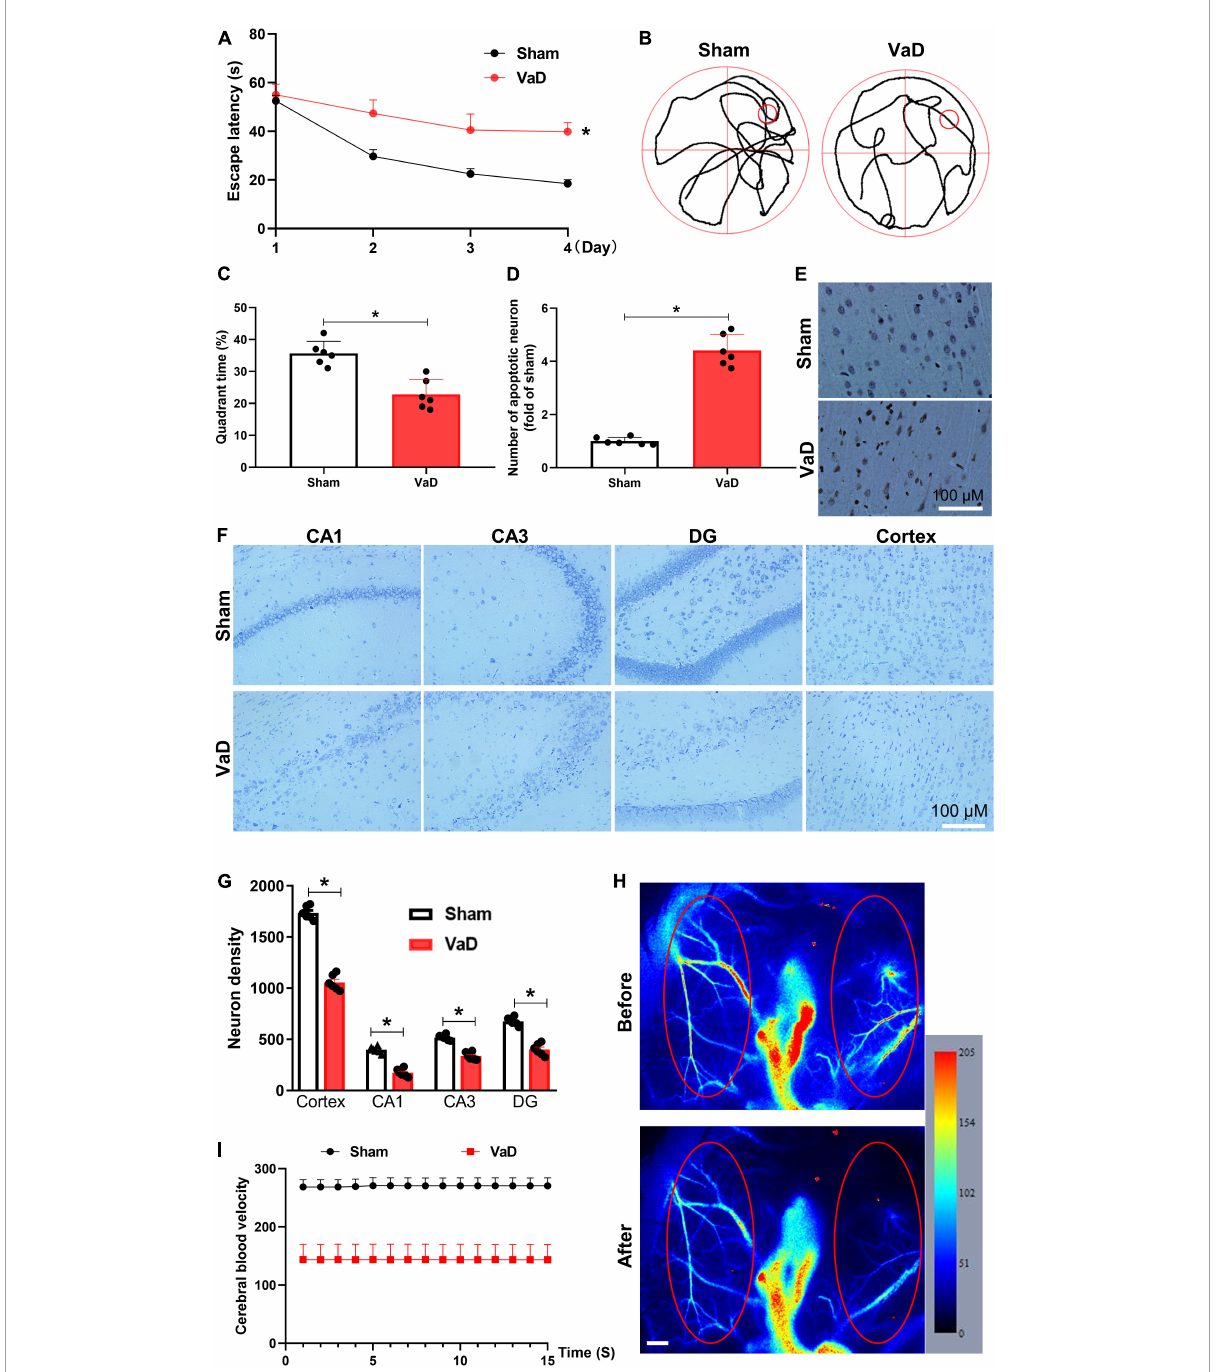
FIGURE3 Establishing of VaD rat model. Sprague-Dawley rats were subjected to bilateral common carotid artery occlusion surgery to induce VaD rat model. Three months later, the Morris water maze (MWM) test was performed, then brains were collected for histopathological analysis. (A) The trajectory chart. (B) The latency time of rats to reach a hidden platform from day 1 to day 4 were recorded. (C) The percentage of time spent in the platform quadrant was calculated. (D) The statistical chart for TUNEL-positive cells. (E) Representative images of TUNEL staining in the cortex region. Representative images of Nissl staining in the CA1, CA3, DG, and cortex regions (F) , and neuron density (G) . (H) Cerebral blood velocity before and after surgery. Red ellipse represents region of interest. Scale bar, 0.5 mm. (I) The cerebral blood velocity was measured in regions of interest. [ (A–G) : n = 6; (H,I) : n = 3]. * p < 0.05. Data are shown as mean ±